Question: What style of plot is this figure drawn as?
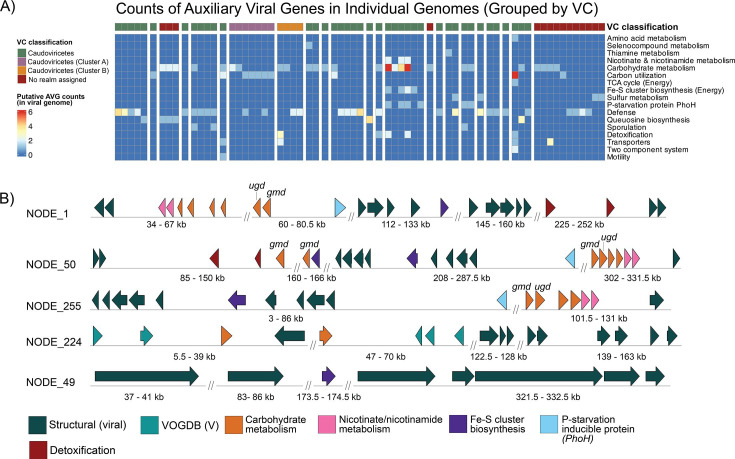
Answer: heatmap